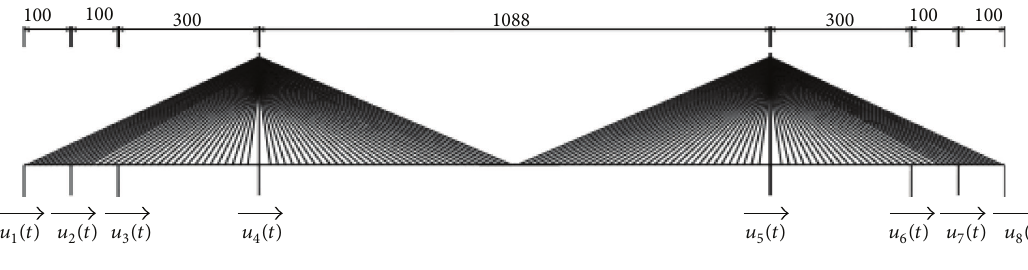
Figure 15: Full traveling time excitation method.